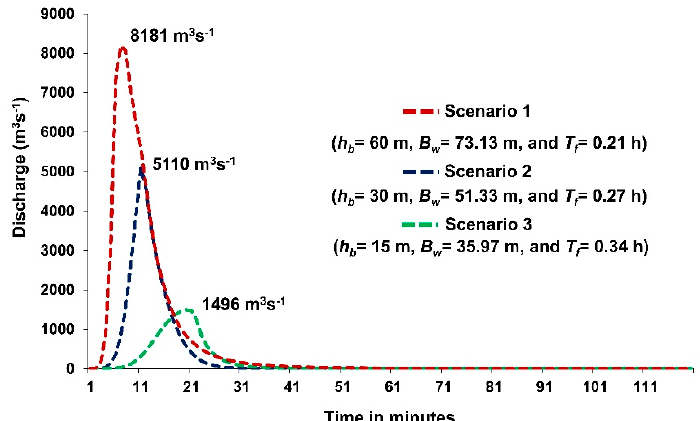
Figure 5. The potential moraine-breach hydrograph of Safed Lake. A peak discharge of 8181 m 3 s − 1